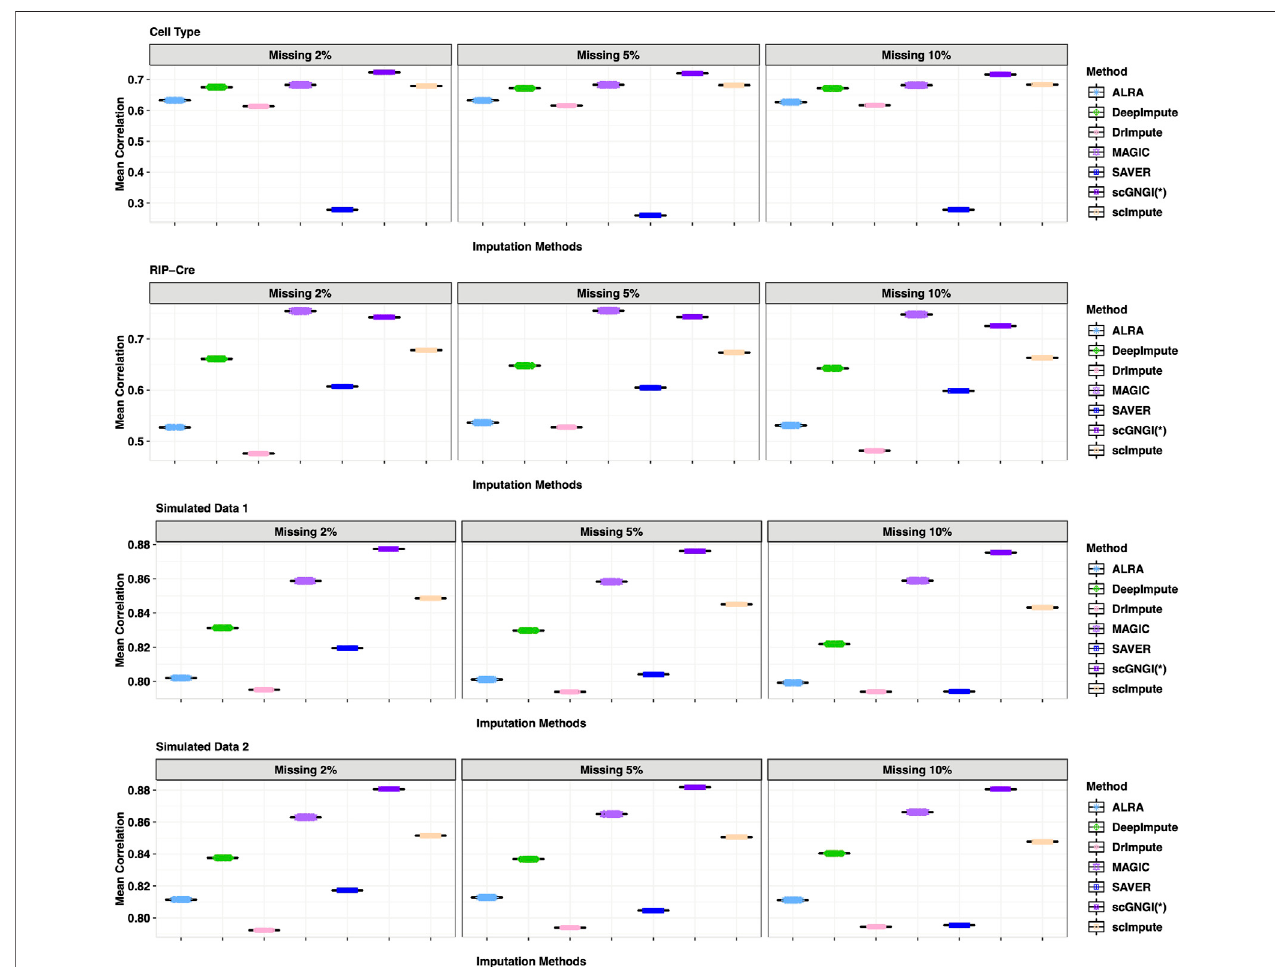
FIGURE 2 | Correlation between the masked truth and imputed values by using different methods in the scRNA-seq data masking experiments. Rows represent the four different datasets (Cell Type, RIP-Cre, Simulated Data 1, and Simulated Data 2). Columns represent three different masking percentages (2%, 5, % and 10%). Boxplots represent the correlation values from 60 masking replicates, where the correlation of each cell is calculated in turn and the mean correlation values are plotted across cells.